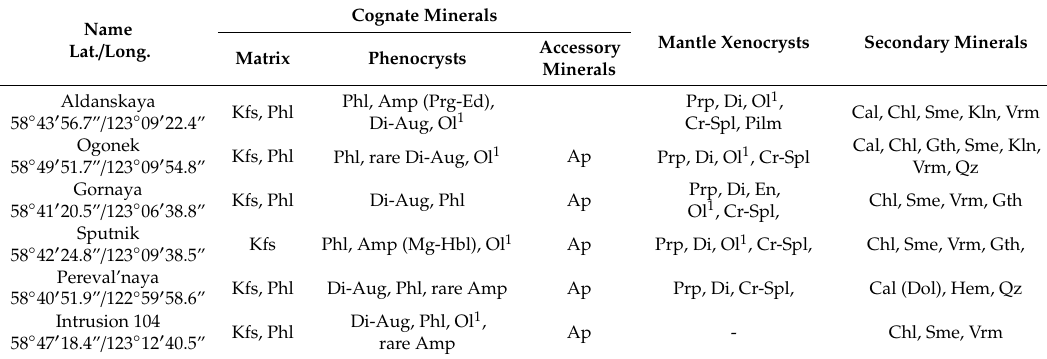
Table 1. The mineral assemblage of Chompolo